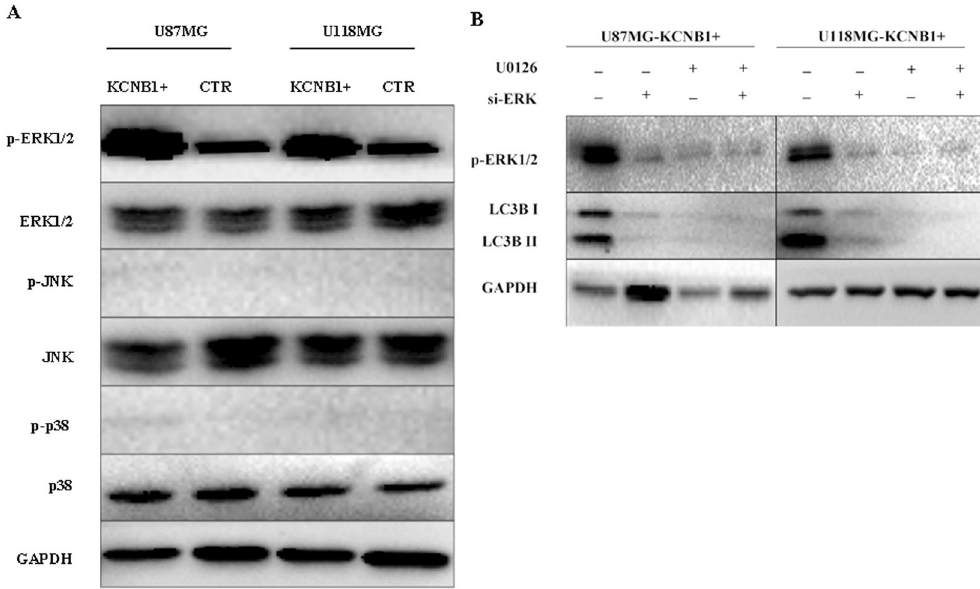
Figure 4. The KCNB1 overexpression induces autophagy via ERK pathway. ( A ) The expression level of phospho-ERK1/2, ERK1/2, phospho-JNK1/2, JNK1/2, phospho-p38, and p38 were detected by western blot analysis in U87MG and U118MG cells (KCNB1 + vs CTR). ( B ) Western blot analyses of phospho-ERK1/2 and LC3-II were performed in KCNB1 + cells treated by U0126 or